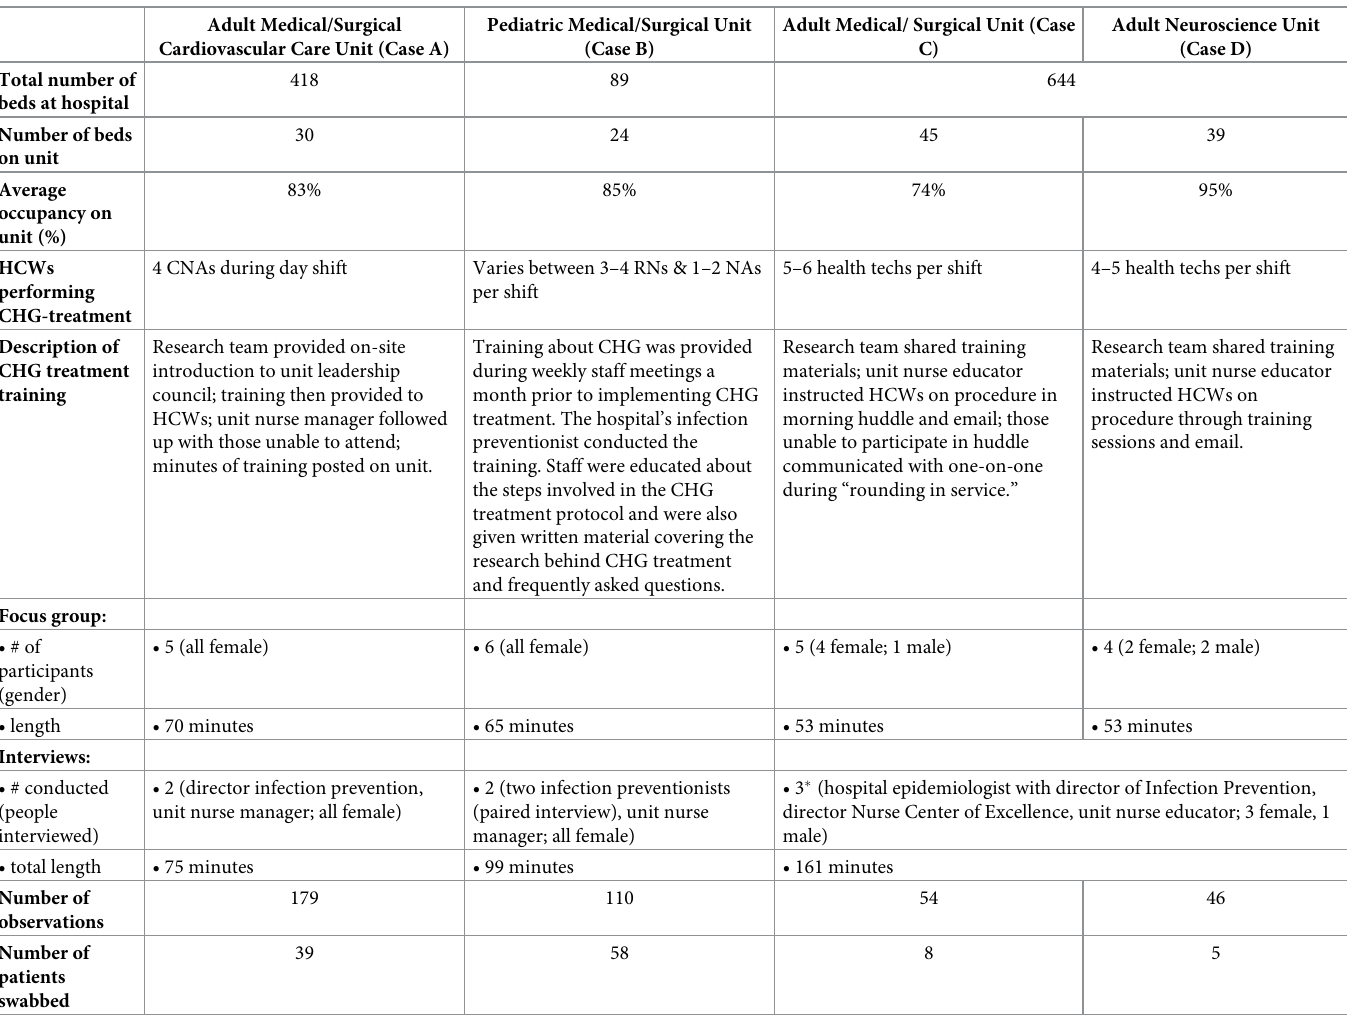
Table 1. Characteristics of participating units and